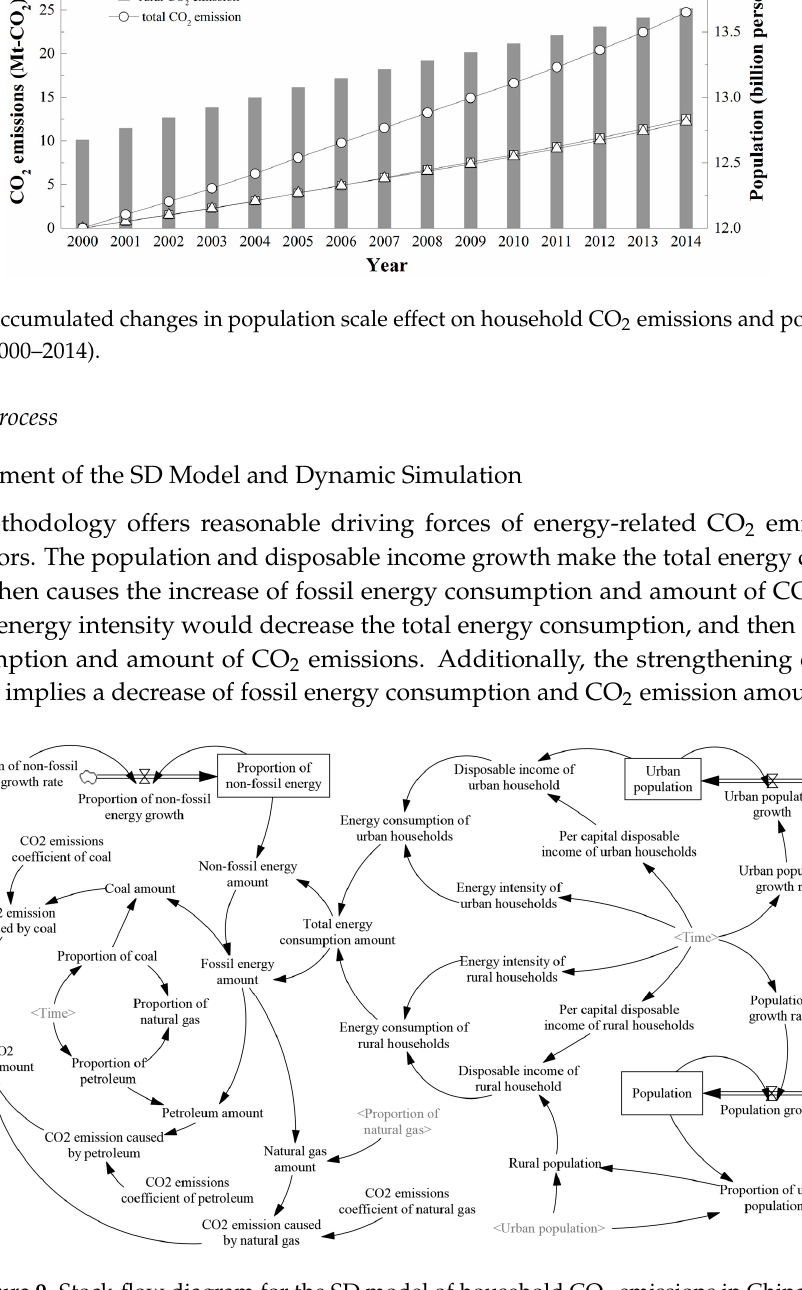
Figure 9. Stock-flow diagram for the SD model of household CO 2 emissions in China.